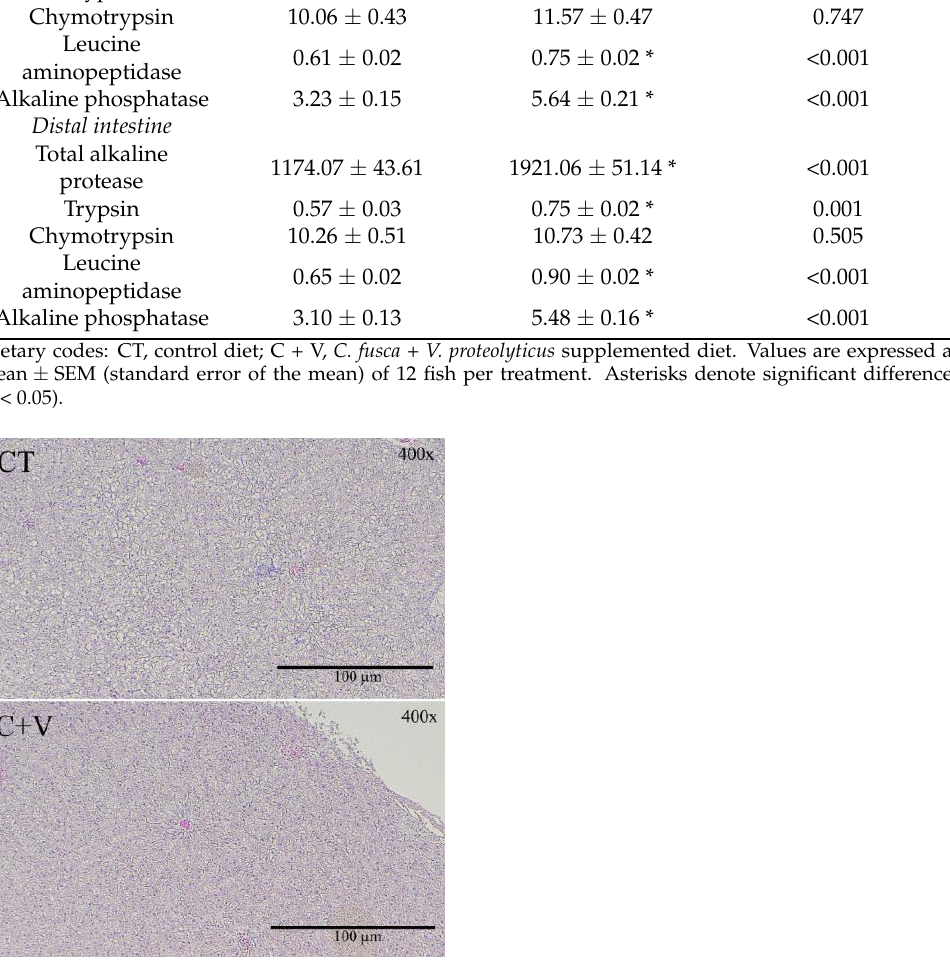
Figure 2. Liver light microscopy details of juvenile C. labrosus fed the control (CT) or C. fusca + V. proteolyticus (C + V ) diets for 90 days. Scale bar: 200 μm.